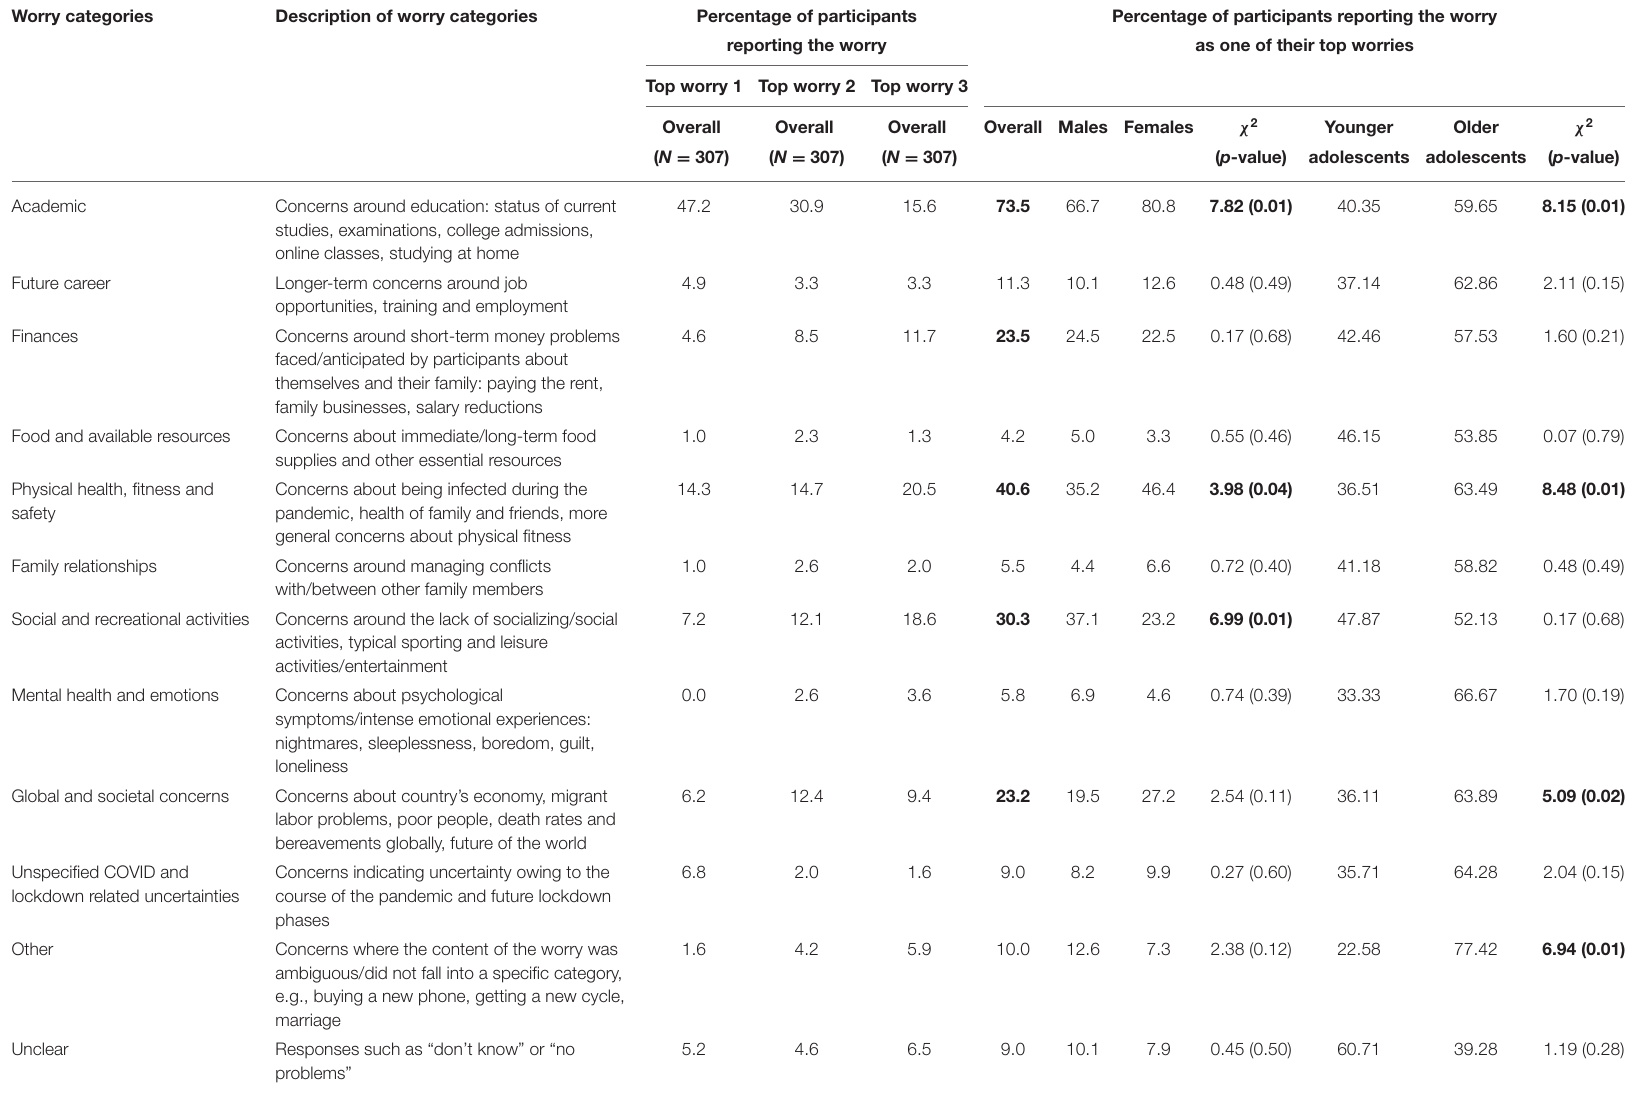
TABLE 4 | Participants’ reported content of top three worries over the last 2